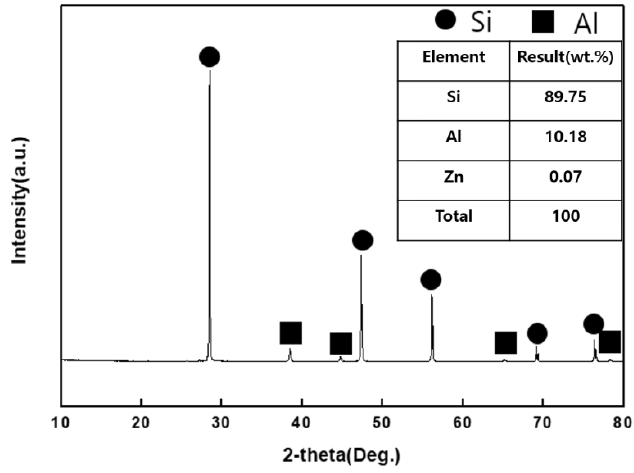
Figure 2. XRD and XRF analysis results for an end-of-life photovoltaic cell sample. Scanning electron microscope (SEM) mapping analysis results of the front and back side of the photovoltaic cell are shown in Figure 3. The parts circled in red in Figure 3 were analyzed by SEM mapping analysis (JEOL Ltd., Seoul, Korea). Through SEM mapping analysis, it was found that Si, Ag, and Al were mainly present on the front side of the photovoltaic cell and Al and Ag were mainly present on the back side.